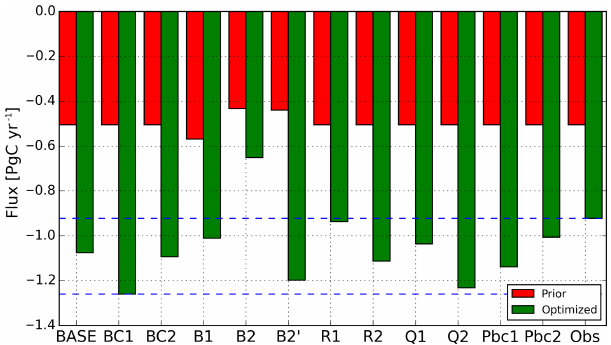
Figure 11. North American 2010 annual net biosphere fluxes (PgCyr − 1 ) estimated from an ensemble of CTDAS-Lagrange runs with different prior biosphere fluxes, different CO 2 BCs, and model setup choices. The dashed blue lines refer to the range of the en- semble estimates − 0 . 92 to − 1 . 26PgCyr − 1 excluding the B2 run. See Table 2 for an overview of all